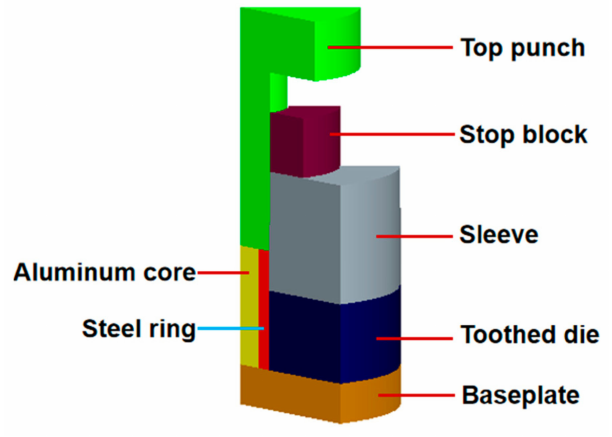
Figure 7. The thermo-mechanical coupled FE model for hot forging steel/aluminum spur